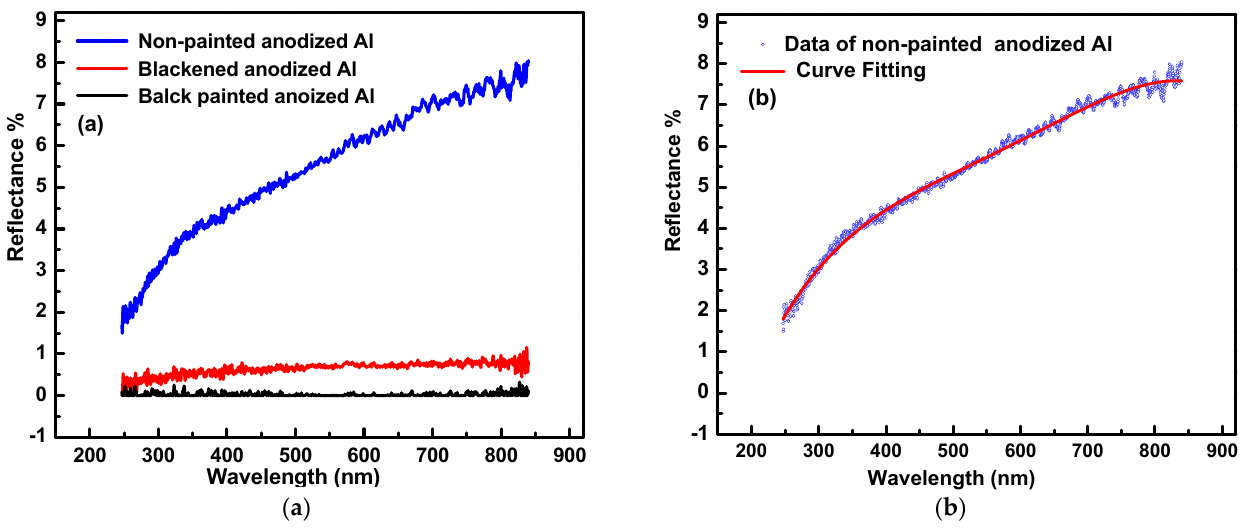
Figure 12. ( a ) Reflectance % of the three used selective surfaces, Al, B. A. Al, and B. P. Al, vs. the applied spectrum; ( b ) The curve fitting for the Al surface was found to be of the fourth-degree polynomial relation, such that: